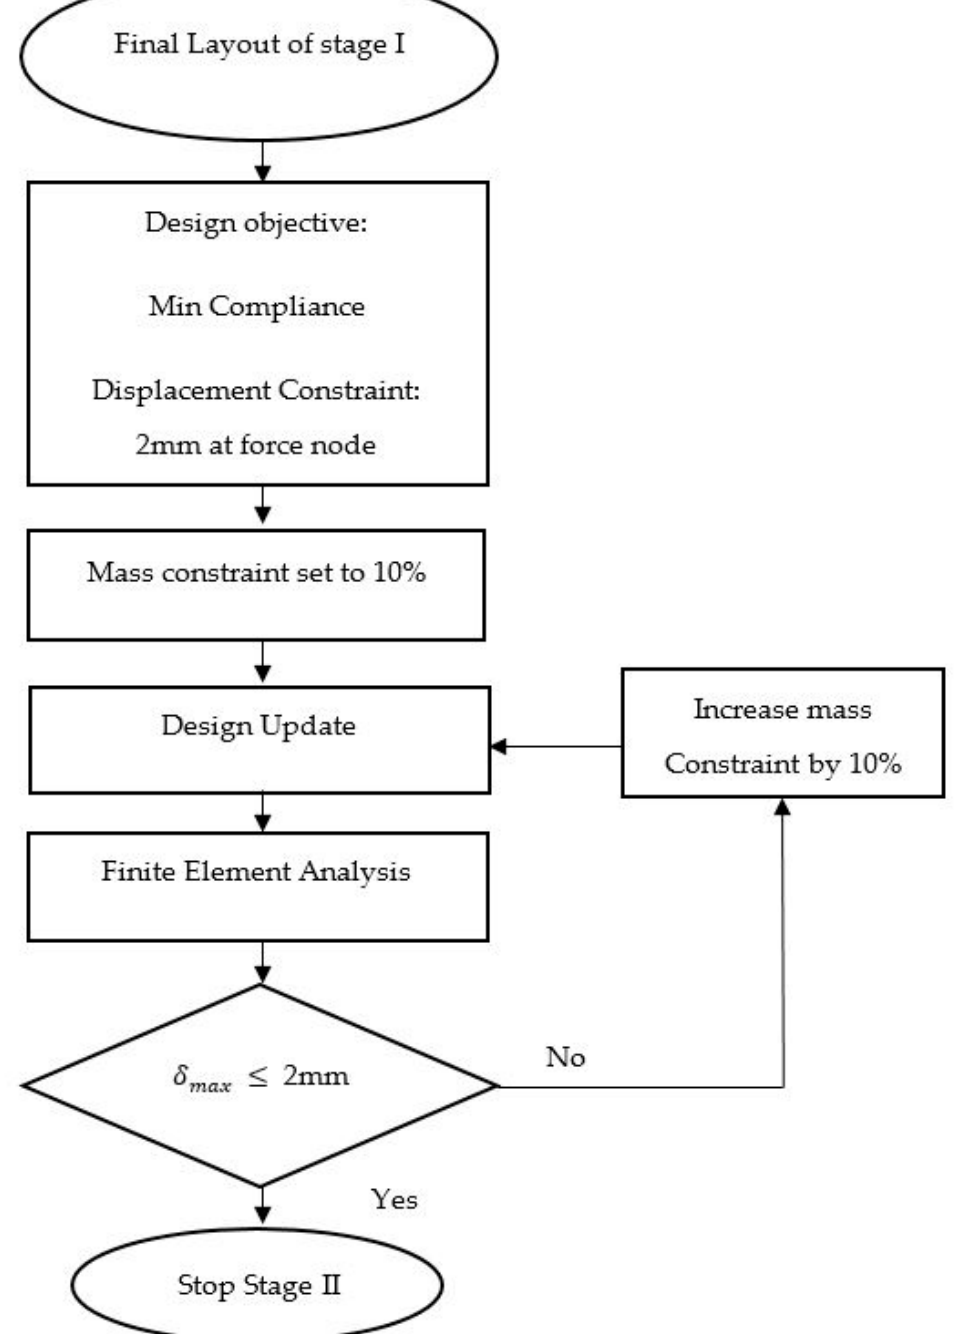
Figure 3. Stage 2 flowchart to reduce population by using topology optimization.